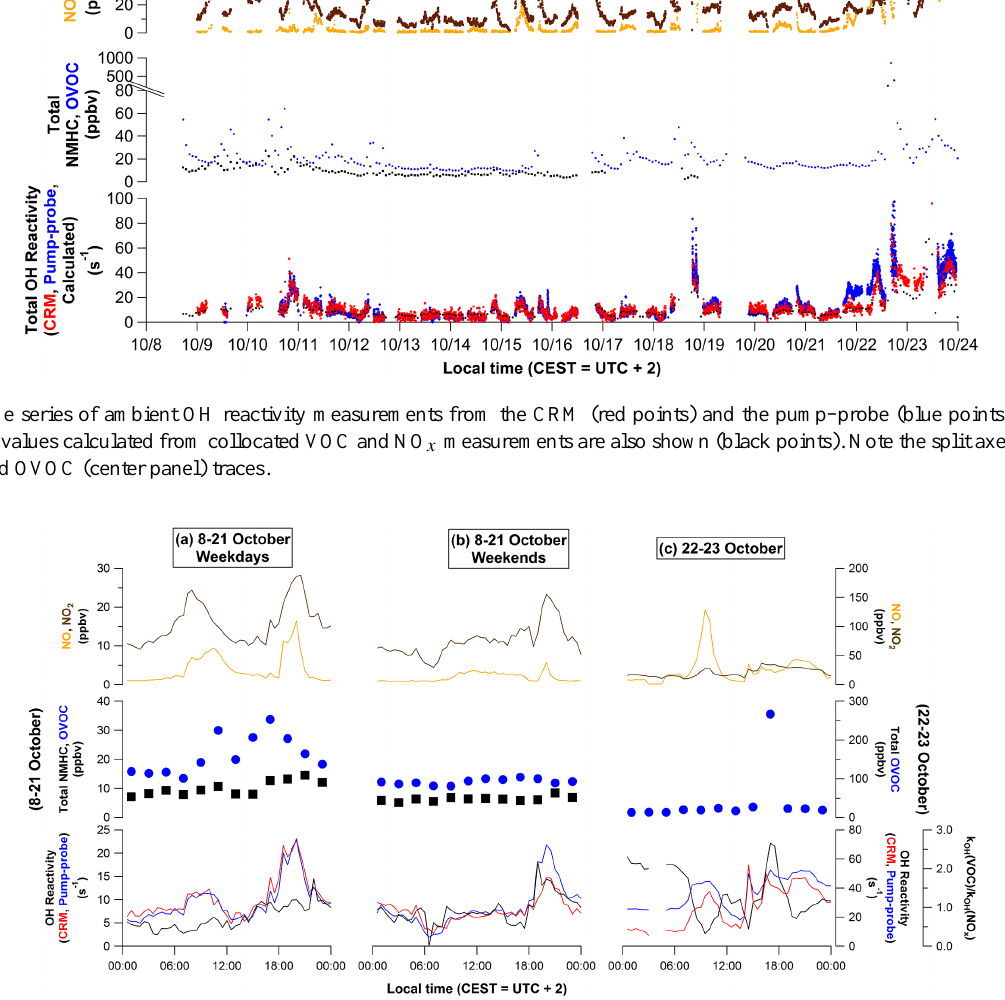
lower than 40 ppbv. Similar trends are observed on the